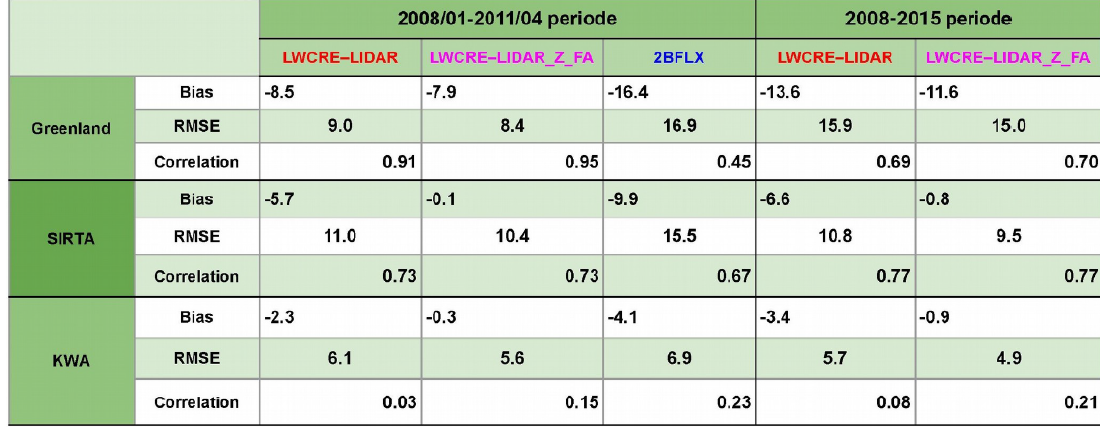
Table 1. Bias, root-mean-squared error (RMSE) and correlation coefficient between satellite products and ground-based